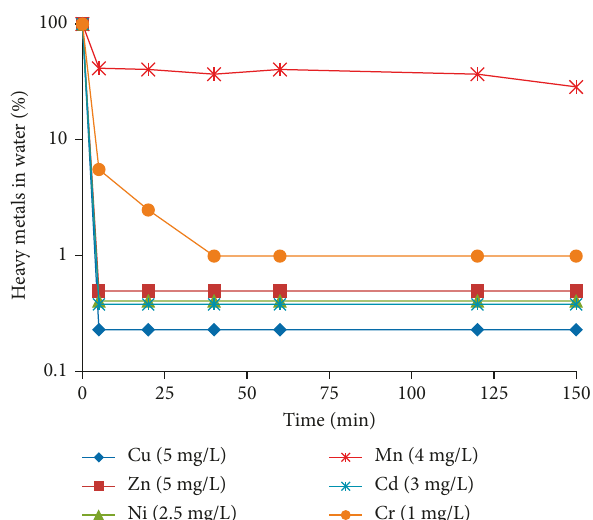
Figure 5: Kinetic profiles of heavy metals in artificially contam- inated water treated with multicomponent nanoparticles.